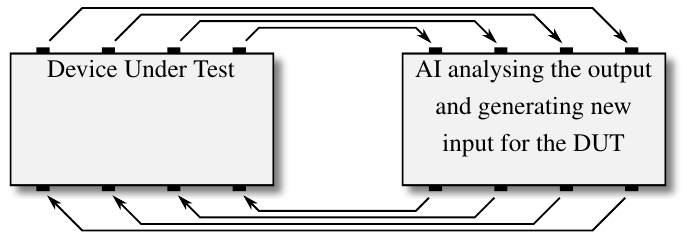
Figure 6. The feedback loop that is implemented for coverage-driven test generation using machine learning algorithms: an AI retrieves the output generated by a given system and generates new input to increase, e.g., a given coverage